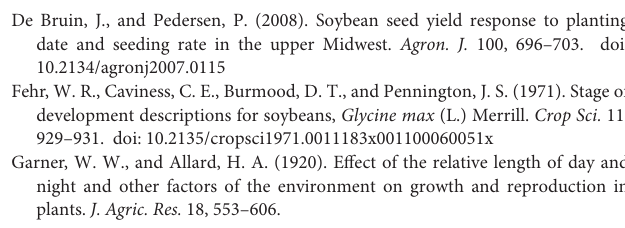
Supplementary Table 3 | Least-square means, Standard Error, and Conservative T-grouping of Intensity of Green Color ( IGC ) per cultivar, planting and harvest date combination analyzed on a split-split block design with block and environment as random factors. Levels not connected by same letter are significantly different at α =